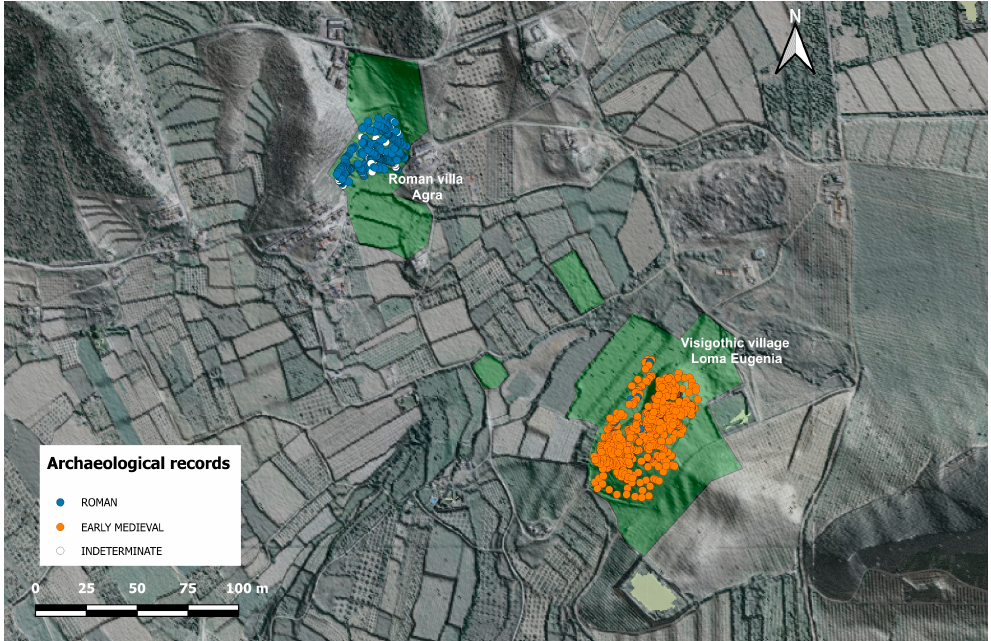
Figure 4. The LE study area, showing the individual localisations of records in the Roman villa of Agra and the Visigothic village of